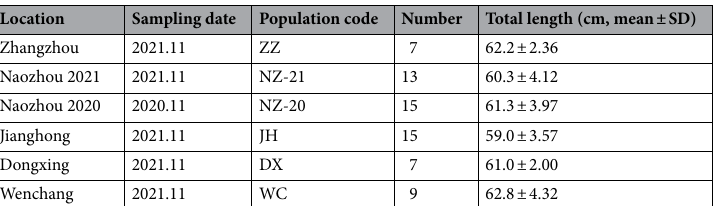
Table 1. Sampling locations and sample characteristics of fourfinger threadfin, Eleutheronema tetradactylum , collected from China.